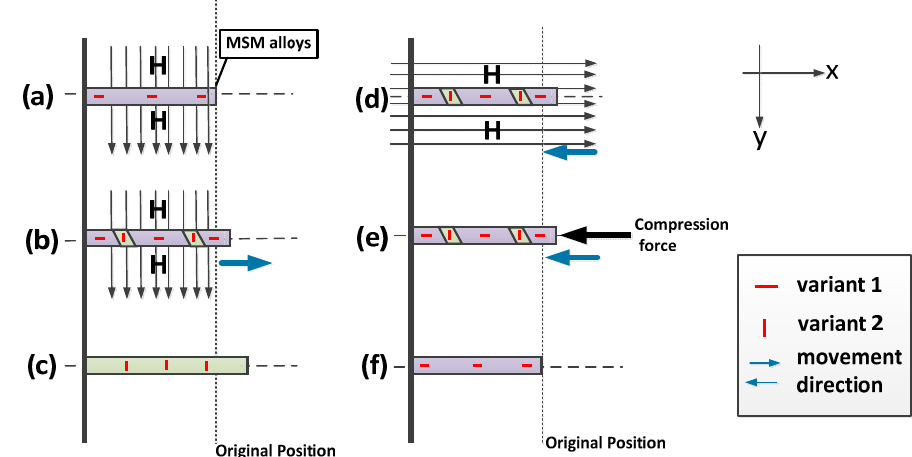
Figure 1. Operational principle of MSM alloys ( a ) MSM alloys have only variant 1 in the first state; ( b ) With the strong magnetic field (>0.7 T) in the y -direction, the MSM element elongates in the x -direction. Elongation will stop when all the twin-variants switch to variant 2; ( c ) Under small or absence of a magnetic field, MSM alloys can hold their length; ( d ) MSM alloys can contract with the provision of magnetic field in the x -direction; ( e ) MSM alloys can contract with the provision of compressive force; ( f ) MSM alloys can return to its original position through process ( d ) or ( e ) [10].